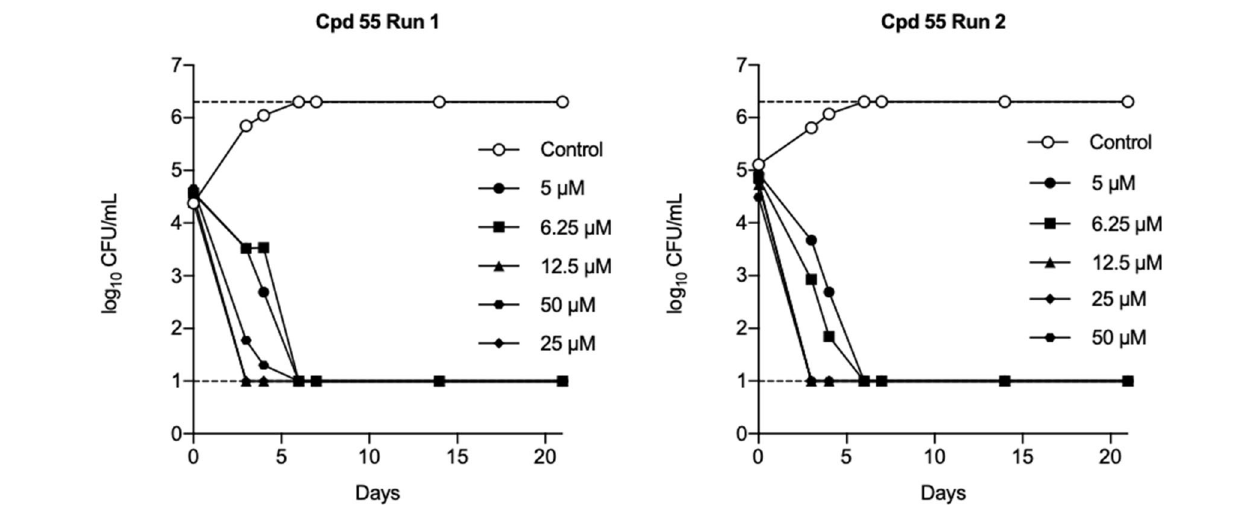
FIGURE 2 | Kill kinetics for a representative compound. M. tuberculosis was cultured aerobically and exposed to compound 55 . Viable bacteria were determined by serial dilution and plating onto agar plates for 3 to 4 weeks. Independent experiments are shown. The control was 2% DMSO. The upper and lower limits of detection are